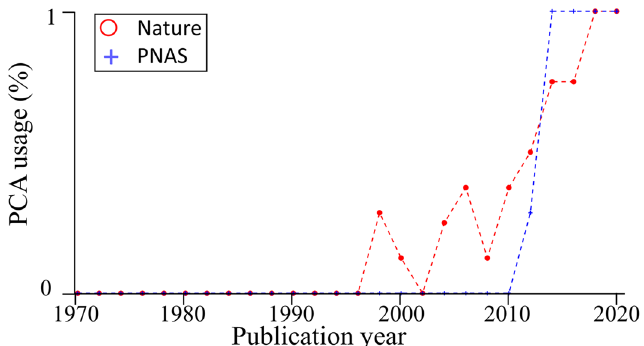
Figure 25. Evaluating the usability of a PCA in population genetic publications by sampling four random population genetic papers per year from Nature and PNAS. The percent of publications that used at least one PCA is